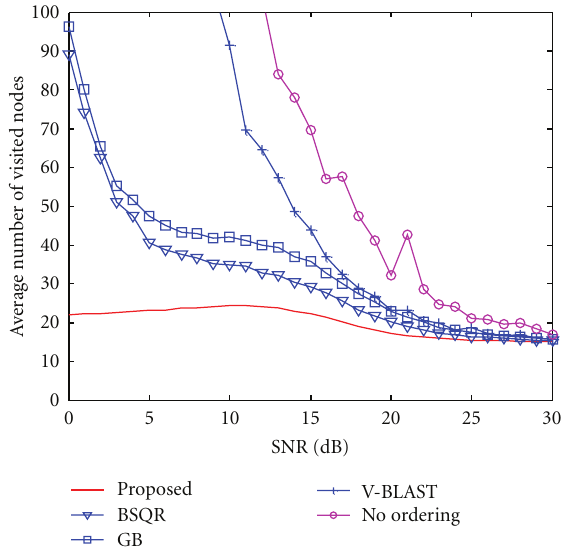
Figure 4: Complexity comparison under five ordering schemes for 4 × 4 64QAM